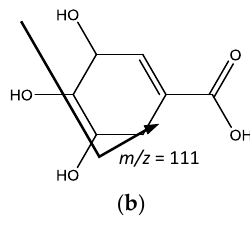
Figure 7. ( a ) Protochatechuic acid and ( b ) Shikimic acid structure and main fragments.